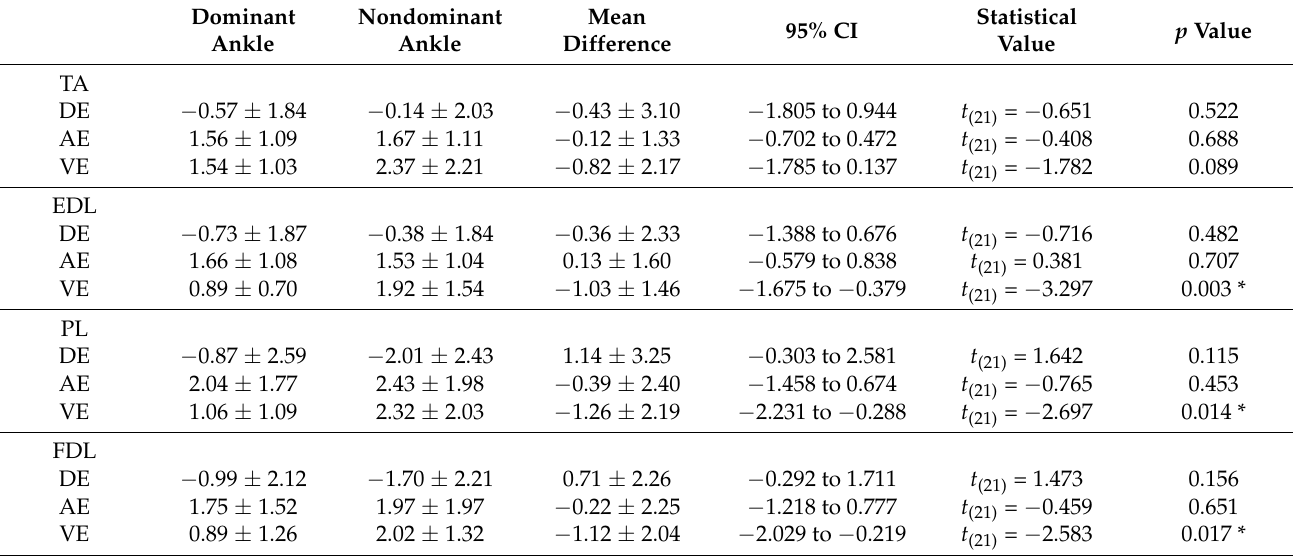
Table 2. Differences in muscle perception performance between the dominant and nondominant ankles of healthy partici- pants ( n = 22).